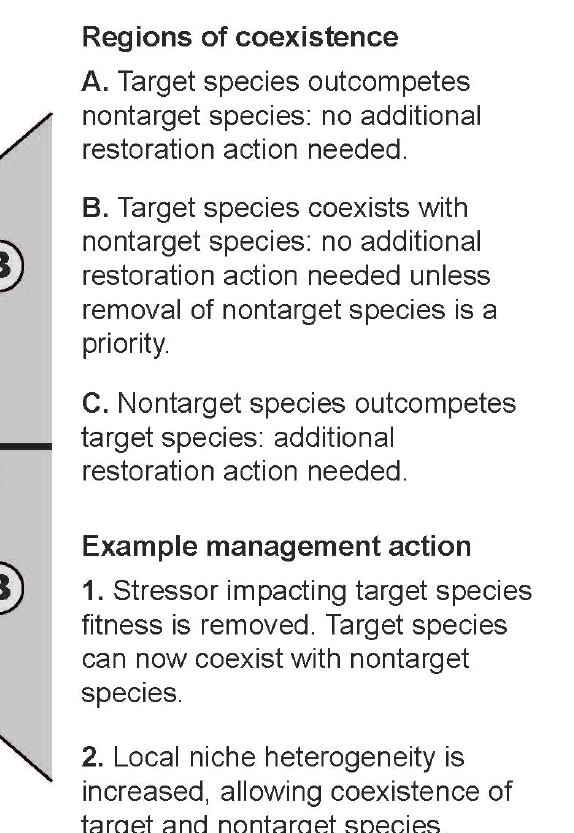
Fig. 5 . The influence of fitness and niche differences on species coexistence based on Chesson’s (2000) coexistence theory. Target species interact with nontarget competitors (including exotic species), and the outcome of their interactions will influence restoration success. Restoration actions can directly influence competitive interactions by influencing either species fitness or niche opportunities (adapted from Adler et al. 2007, MacDougall et al.